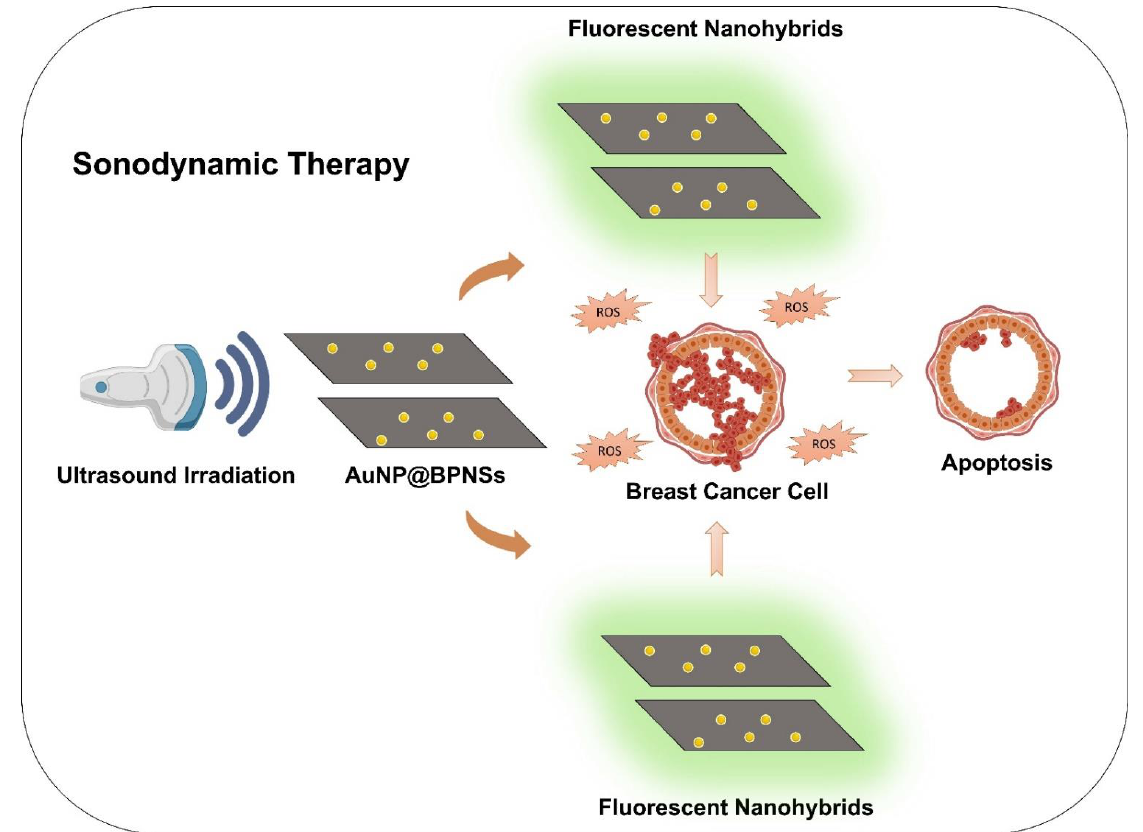
Figure 6. Sonodynamic therapy of breast cancer using AuNP-BPNS nanohybrid.